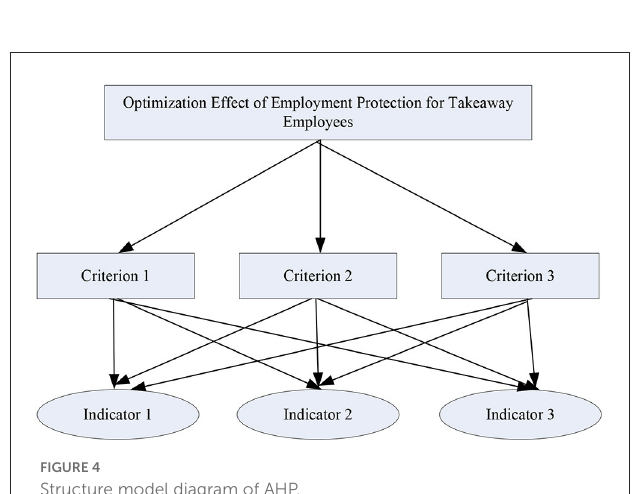
FIGURE4 Structure model diagram of